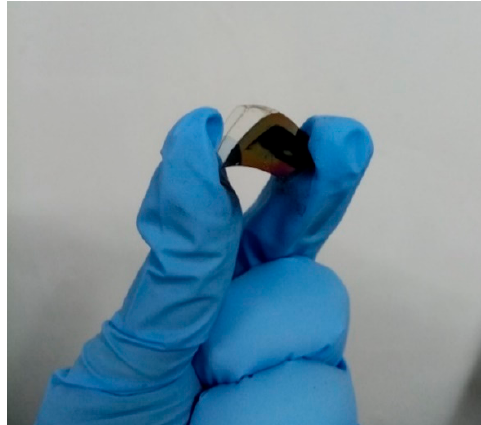
Figure 7. Flexible perovskite solar cell based on carbon electrode.